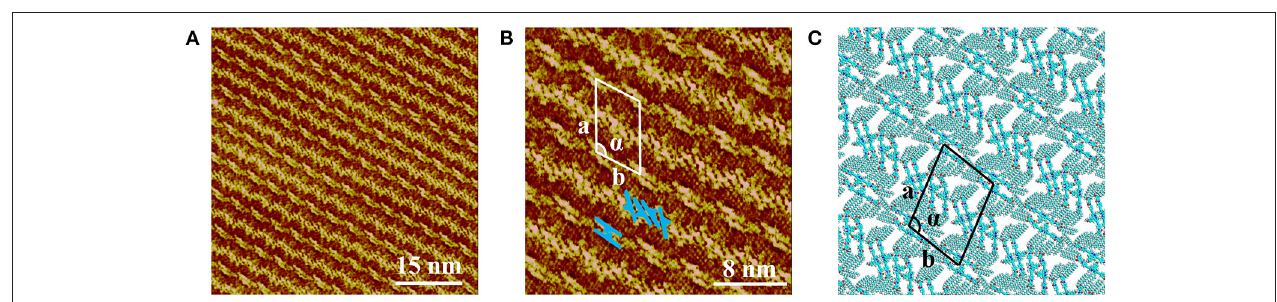
FIGURE 2 | STM images of LC-amide-1 assembly structure at the HOPG/1-phenyloctane interface: (A) Large scale; (B) High resolution. Tunneling conditions: I set = 366.2pA, V bias = 520.3mV. (C) The simulated molecular packing